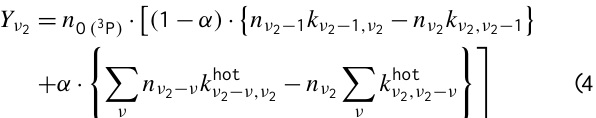
dissociative recombination reactions in the MLT. O + 2